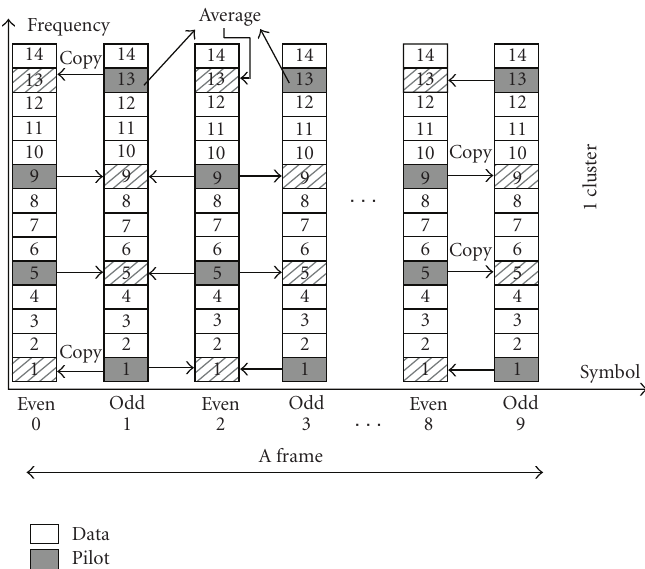
Figure 5: Linear interpolation in